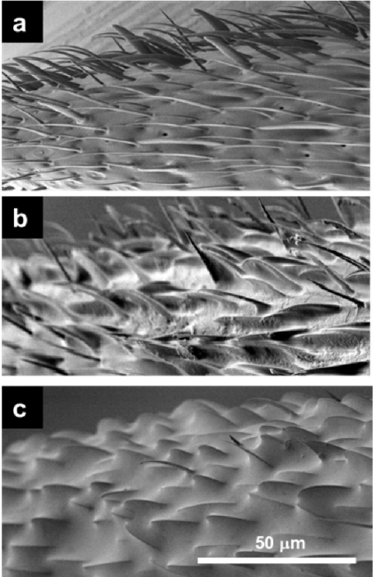
Figure 1. NanoSuit/SEM image of antennal surface. Representative images of antennal surfaces of the tip segments in different individual ants before the antenna cleaner removal operation ( a ), and at 24 ( b ) and 48 h after that ( c ), respectively. The scale is common for ( a – c ).